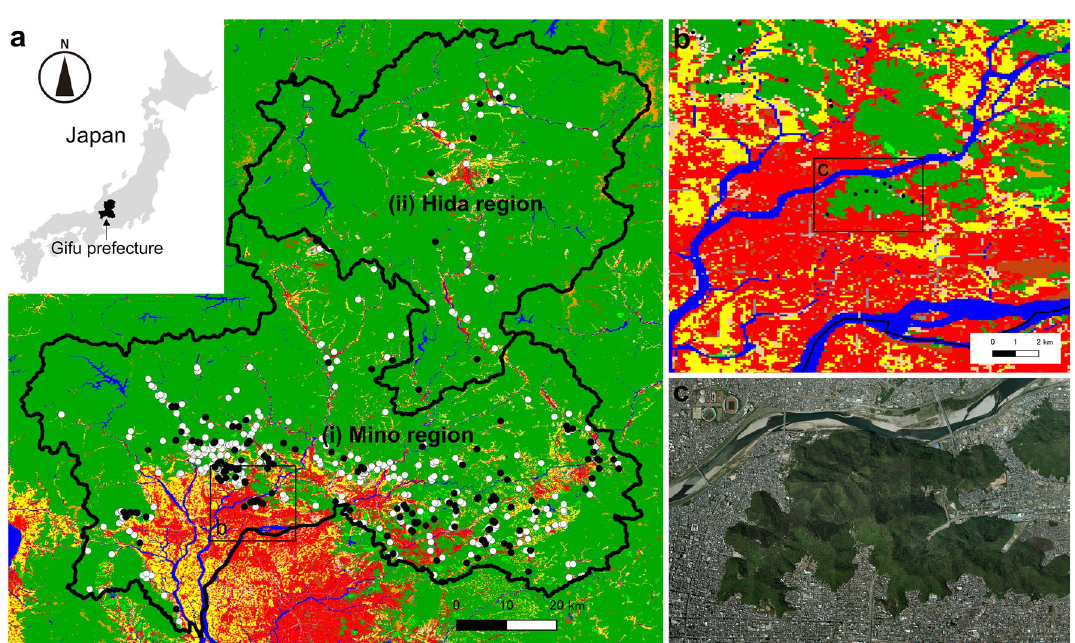
Figure 2. Spatial distribution of anti- T. gondii antibody-positive wild boars in Gifu Prefecture, Japan. ( a ) Locations of the capture points of the examined wild boars. Black and white filled circles represent each capture point for the seropositive and negative wild boars, respectively. The colors on the map indicate the land use status as follows. Green: forests, Red: residential areas, Yellow: rice fields, pale orange: other agricultural land, Orange: wastelands, Blue: rivers and lakes, Light green: golf courses. Among the 663 capture points, multiple wild boars were captured at 68 points. When all the wild boars captured at a point were T. gondii -negative, a white filled circle is shown. A black filled circle is shown even when a single animal was T. gondii -positive. Figure was created with Quantum Geographic Information System (QGIS) software (version 3.12.3-Bucure ș ti) 34 . ( b ) Enlarged view of the area surrounded by a square in panel ( a ). Residential areas surrounding the park. ( c ) Aerial photograph of the area shown in panel ( b ). The image was downloaded from the Map and Aerial Photograph Browsing Service (https:// mapps. gsi. go. jp/ mapli bSear ch. do#1) of the Geospatial Information Authority of Japan (GSI). These data were partially processed and